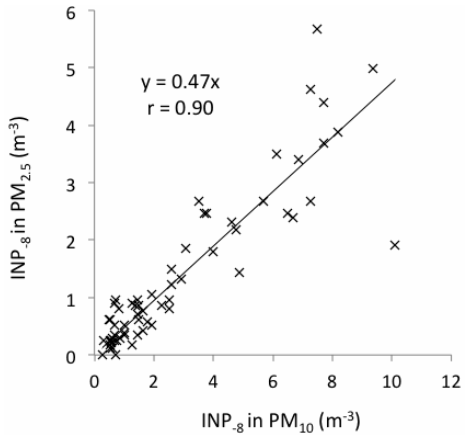
Figure 4. Ice-nucleating particles active at − 8 ◦ C in PM 2 . 5 , relative to their number in PM 10